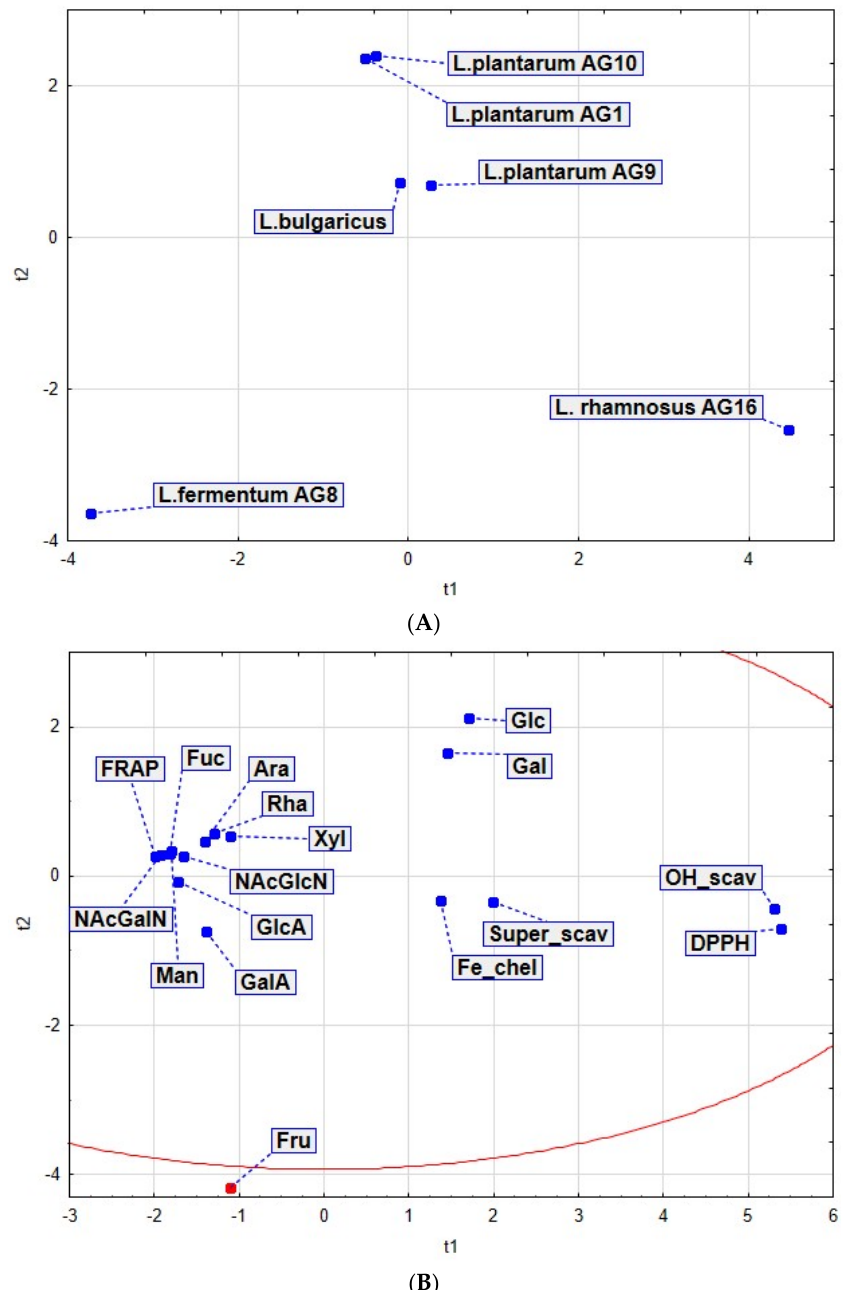
Figure 7. Principal component analysis of antioxidant properties of LAB strains ( A ) and antioxidant properties of EPS ( B ).